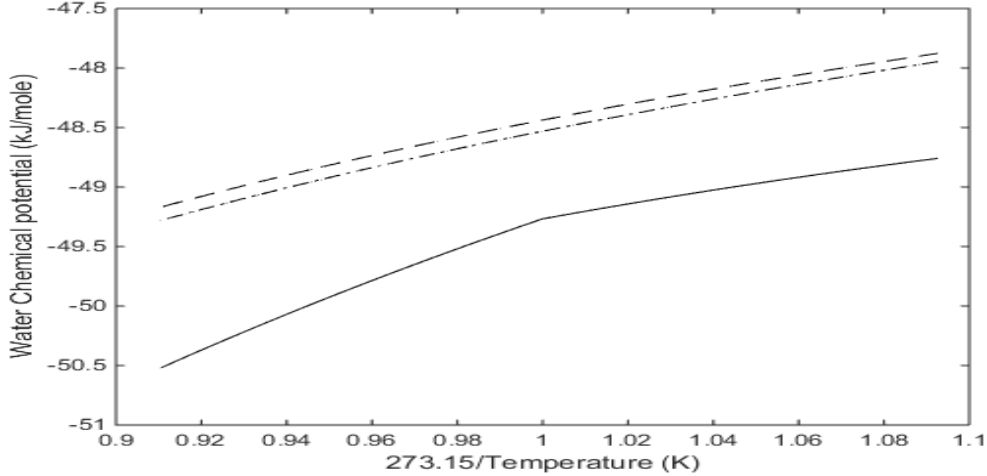
Figure 1. Water chemical potential in empty hydrate of structure I (dash), and in empty hydrate of structure II (dash-dot). Water chemical potential in the ice region (273.15 / T ≥ 1.0) and liquid region (273.15 / T < 1.0) is represented by a solid curve.